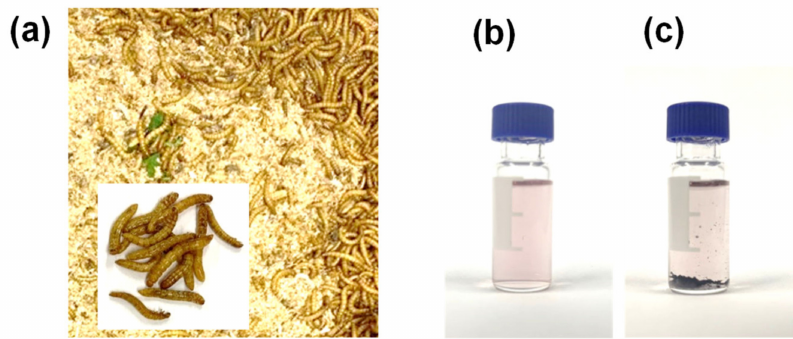
Figure 1. ( a ) Mealworms grown in wheat bran; ( b ) acetonitrile (MeCN) extract of mealworms and ( c ) MeCN extract of mealworms after 24 h in freezer ( − 20 ◦